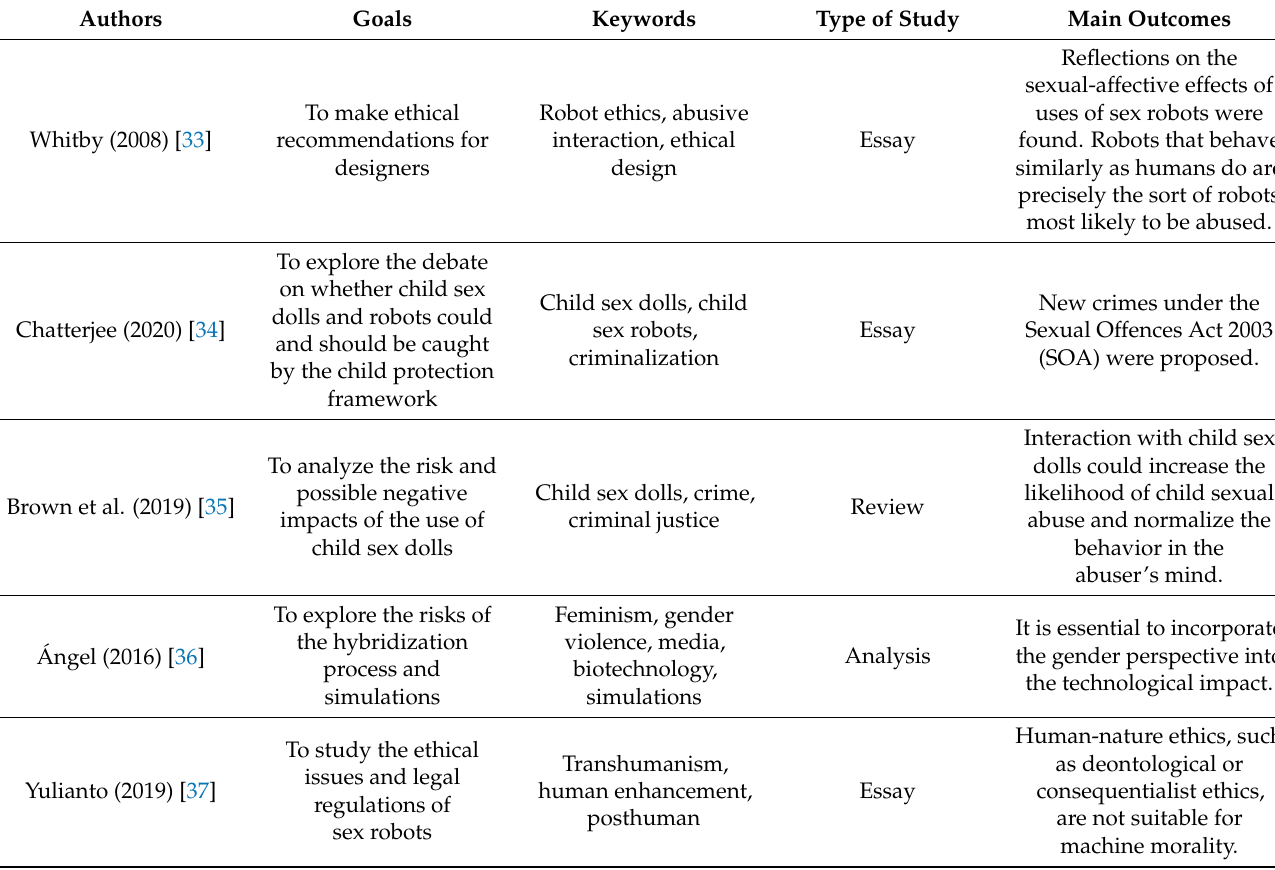
Table 3. Research question 3 (RQ3) about gender and ethics, type of study, and